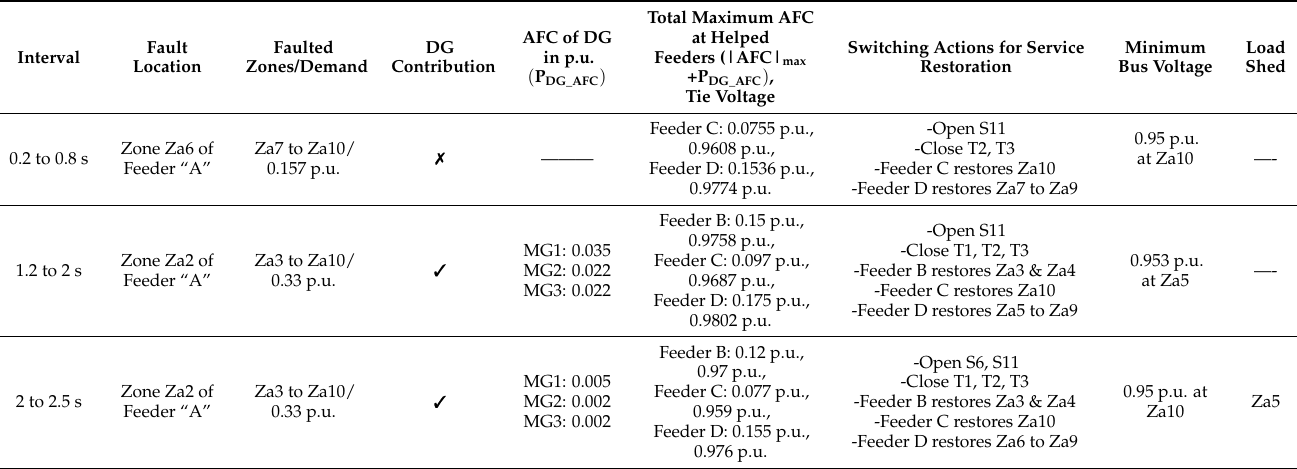
Table 3. Restoration results for the multi-scenario case